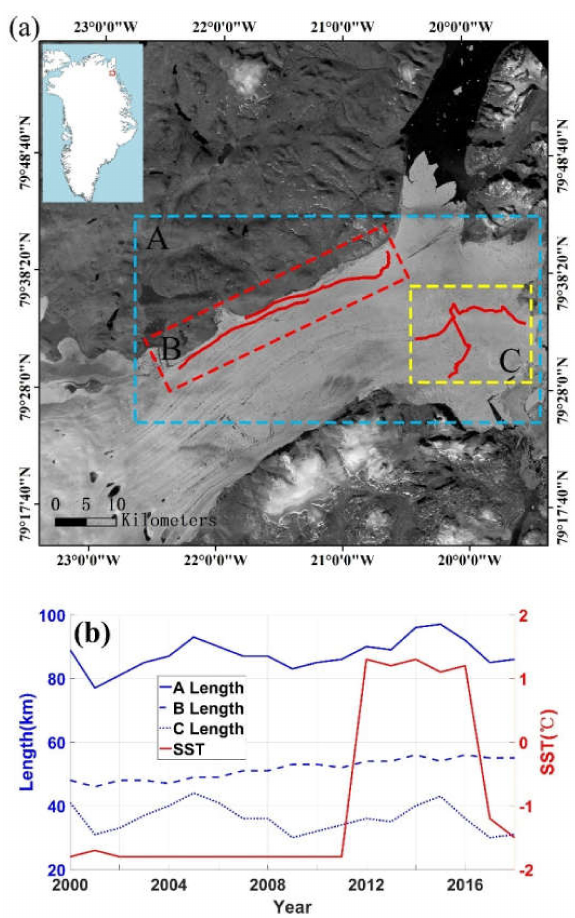
Figure 14. Variations in the length of ocean-sourced basal channel. ( a ) shows the distribution of ocean-sourced basal channel, where the red, yellow and blue dotted boxes represent the total length of ocean source basal channel in region B, region A and region C, respectively. ( b ) shows the changes of ocean-sourced channel length in di ff erent regions and the annual change of SST. The three blue lines show in the legend correspond to the length of ocean sourced basal channel in regions A, B and C respectively (refer to the left y-coordinate for coordinate axes). The solid red line represents the data results of the sampling location of SST in Figure 1a (refer to the y-coordinate on the right of the coordinate